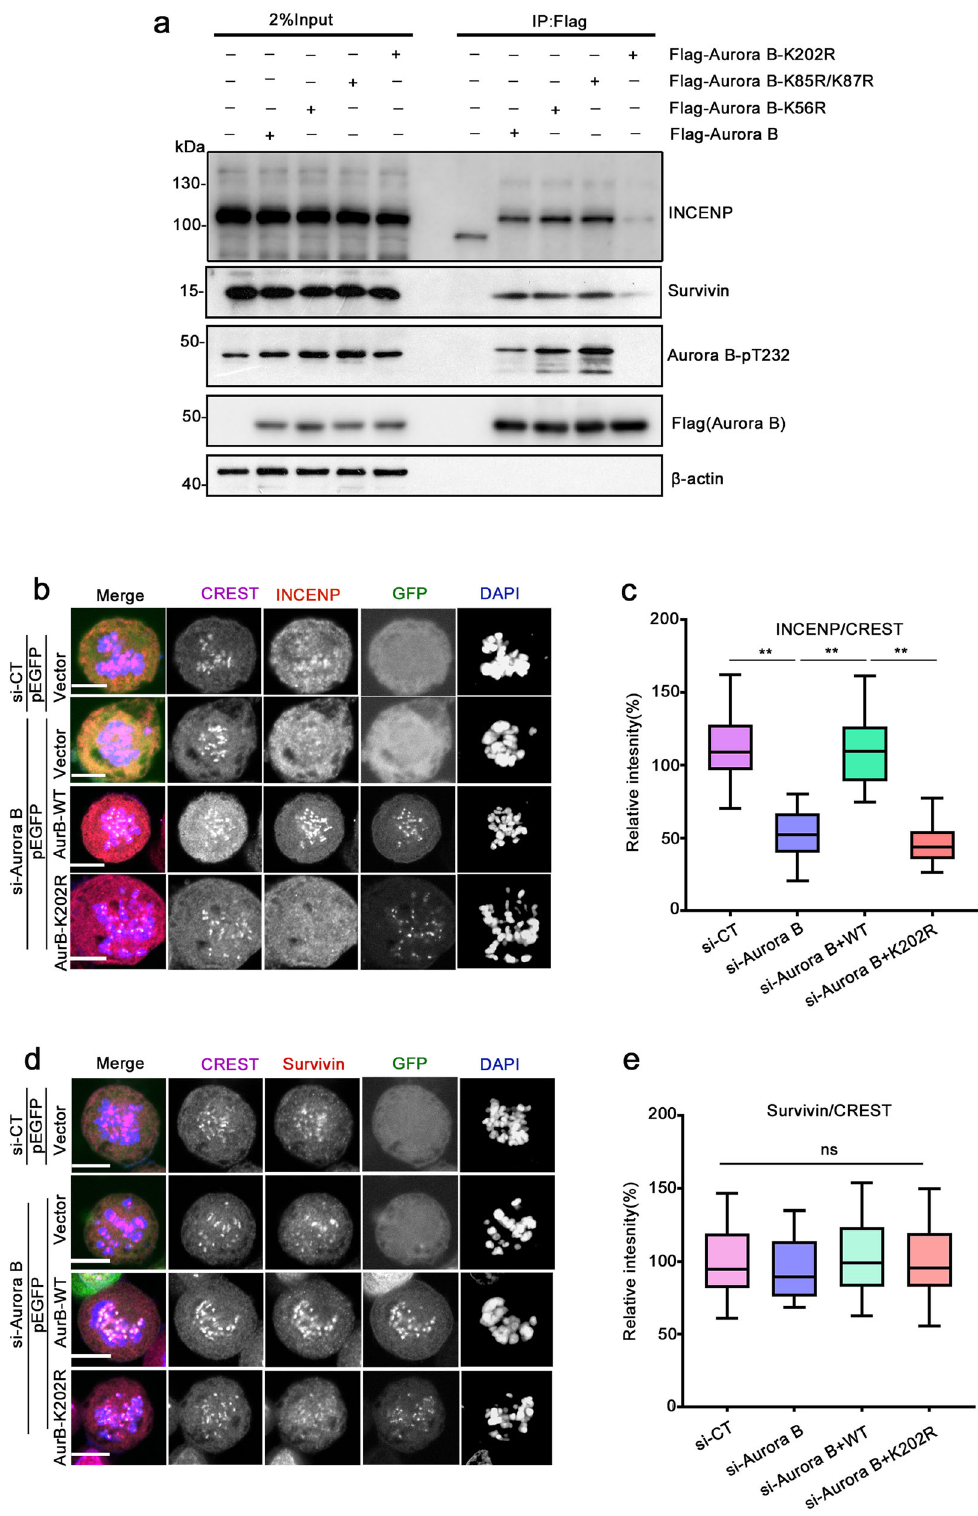
Fig. 5 Ubiquitination of Aurora B at Lys202 facilitates the formation of CPC complex. a Mutation at Aurora B-K202 disturbs the interaction between Aurora B and INCENP/Survivin. HEK293T cells were transfected with the indicated plasmids and then treated with 30 ng/mL NOC for 16 h, arrested at mitosis, and the lysates were subjected to Flag-IP. The immunoprecipitates were separated and blotted with the indicated antibodies. b , d Representative confocal images of centromere localization of INCENP (red) ( b ) and Survivin (red) ( d ) in pEGFP-Aurora B or pEGFP-Aurora B-K202R transfected cells. HeLa cells were treated as described in Fig. 4e. Bar, 5 μ m. c , e Box-and-whiskers plots showing the quanti fi cation of the relative intensity of INCENP or Survivin shown in b or d . Intensities were normalized to the general kinetochore marker CREST. Boxes show the upper and lower quartiles with a line at the median. Whiskers as the extent of 100% of the data. P -values were calculated by GraphPad Prism 8. Data are shown as means ± SD ( n = 15 cells, and six areas for each cell were counted). ** p < 0.01 versus CT, one-way ordinary ANOVA test. COMMUNICATIONS BIOLOGY| (2022) 5:1335